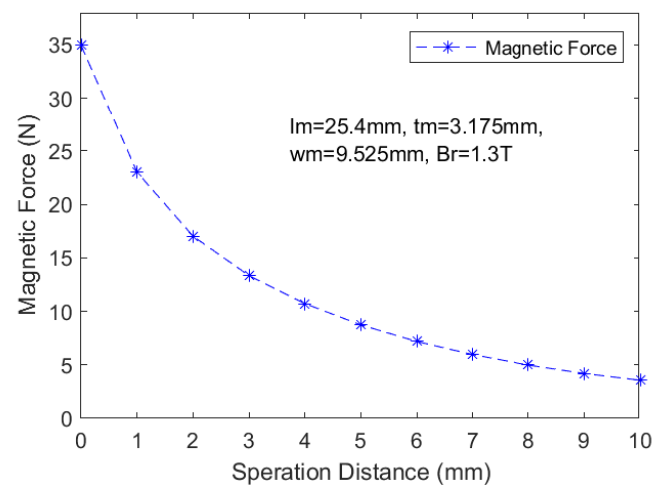
Figure 6. The magnetic force versus the separation distance between